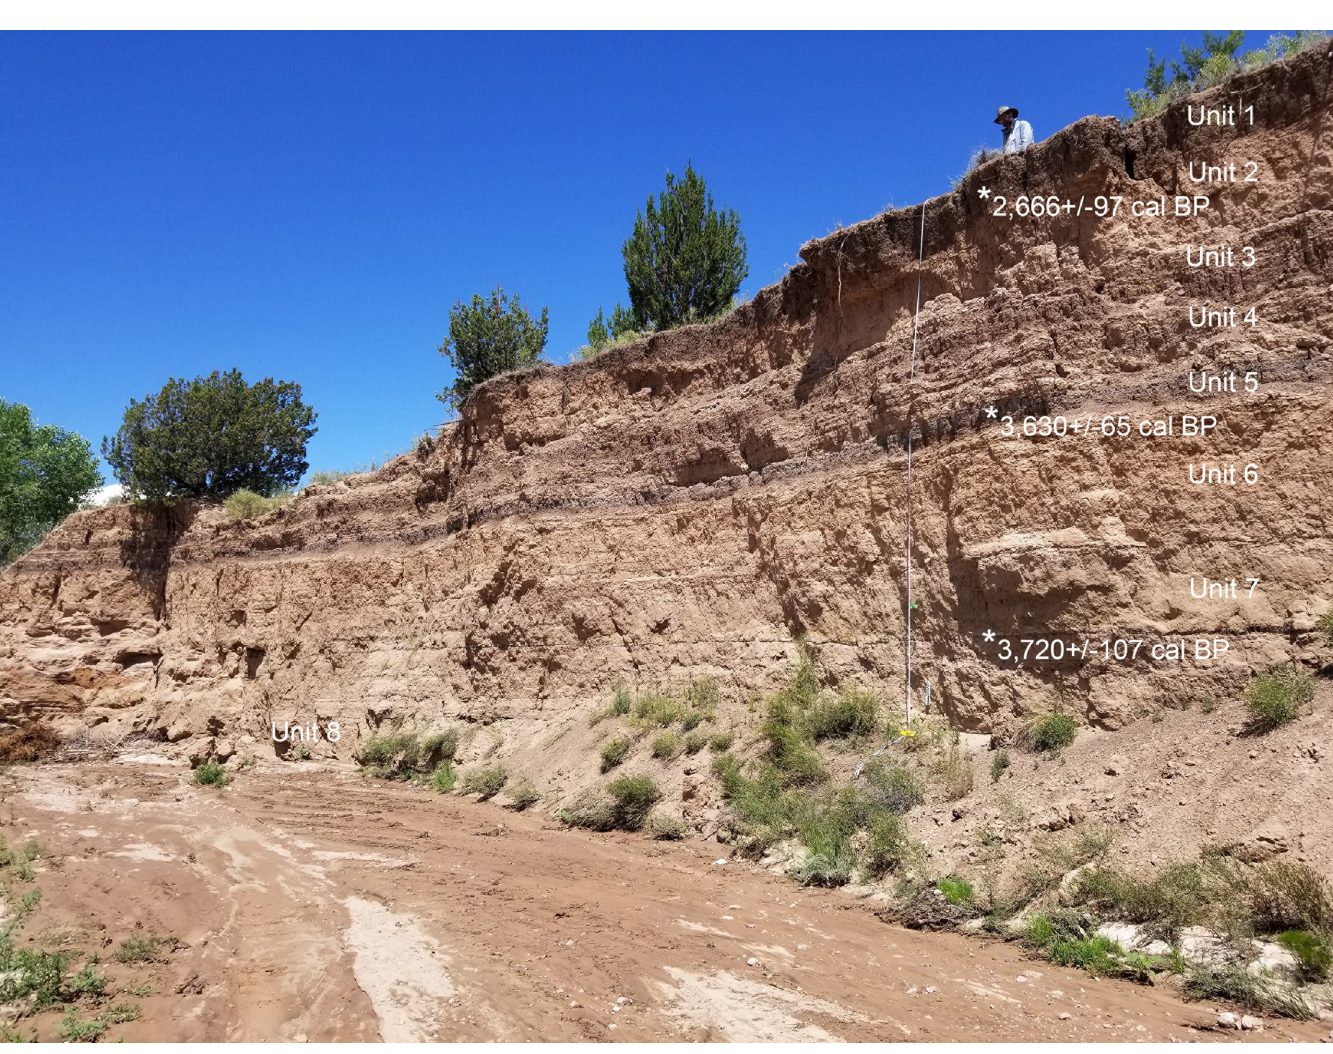
Fig 2. Tesuque Creek East Section showing units and location of C 14